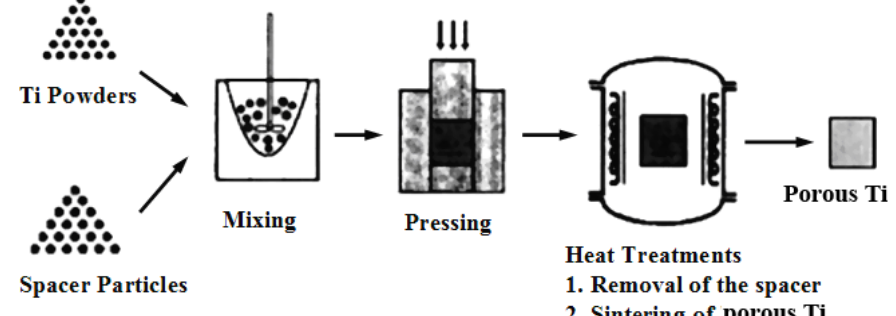
Figure 18. The schematic fabrication process for porous titanium by space holder